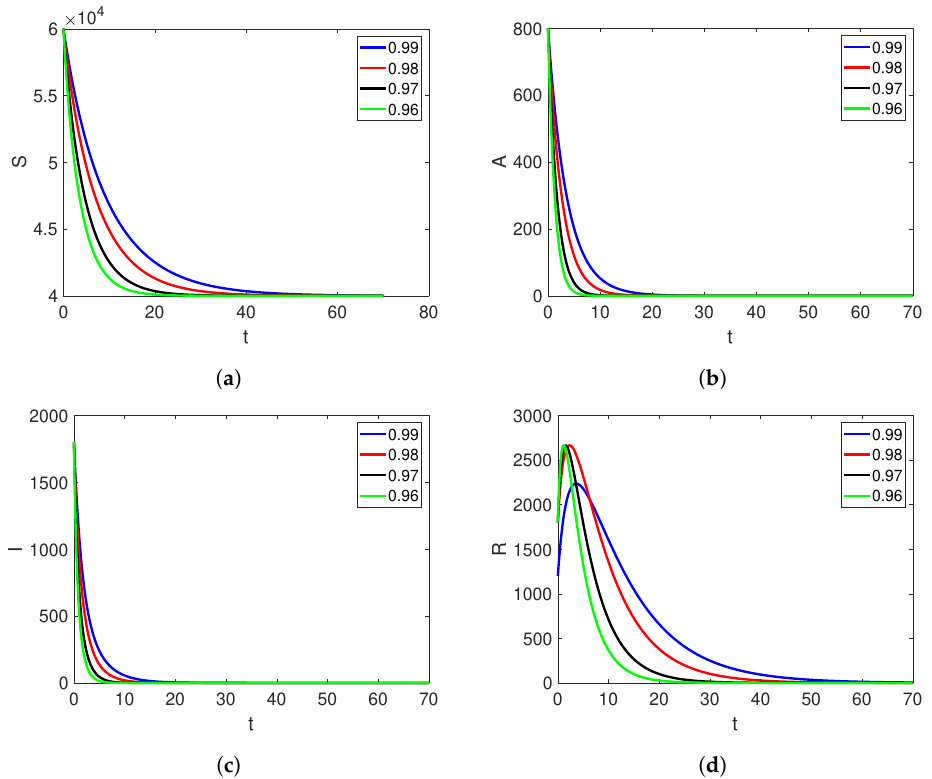
Figure 6. The dynamics of the state variables’ SAIR in model (2) with different fractional orders α vs. time t with initial